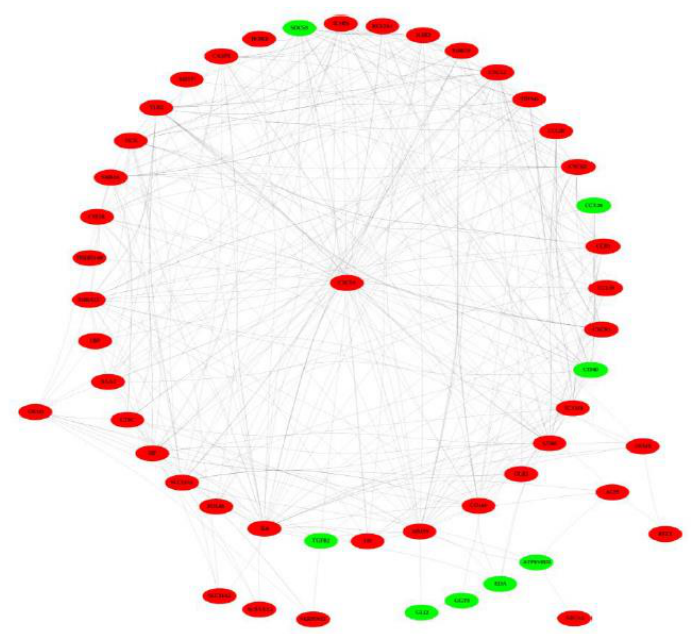
Figure 5. A protein–protein interaction network of differentially expressed genes related to inflammation and immunity. The node in red and green, respectively indicated that the gene was upregulated and downregulated in on late lactation compared with peak lactation.